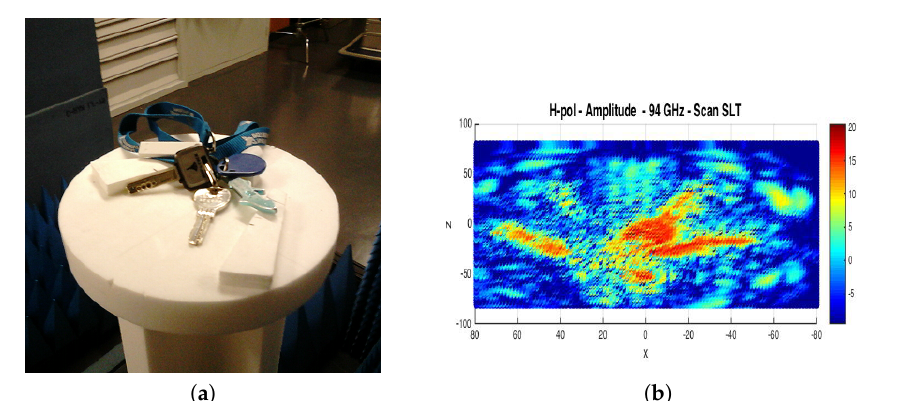
Figure 5. ( a ) Set of keys; ( b ) radar